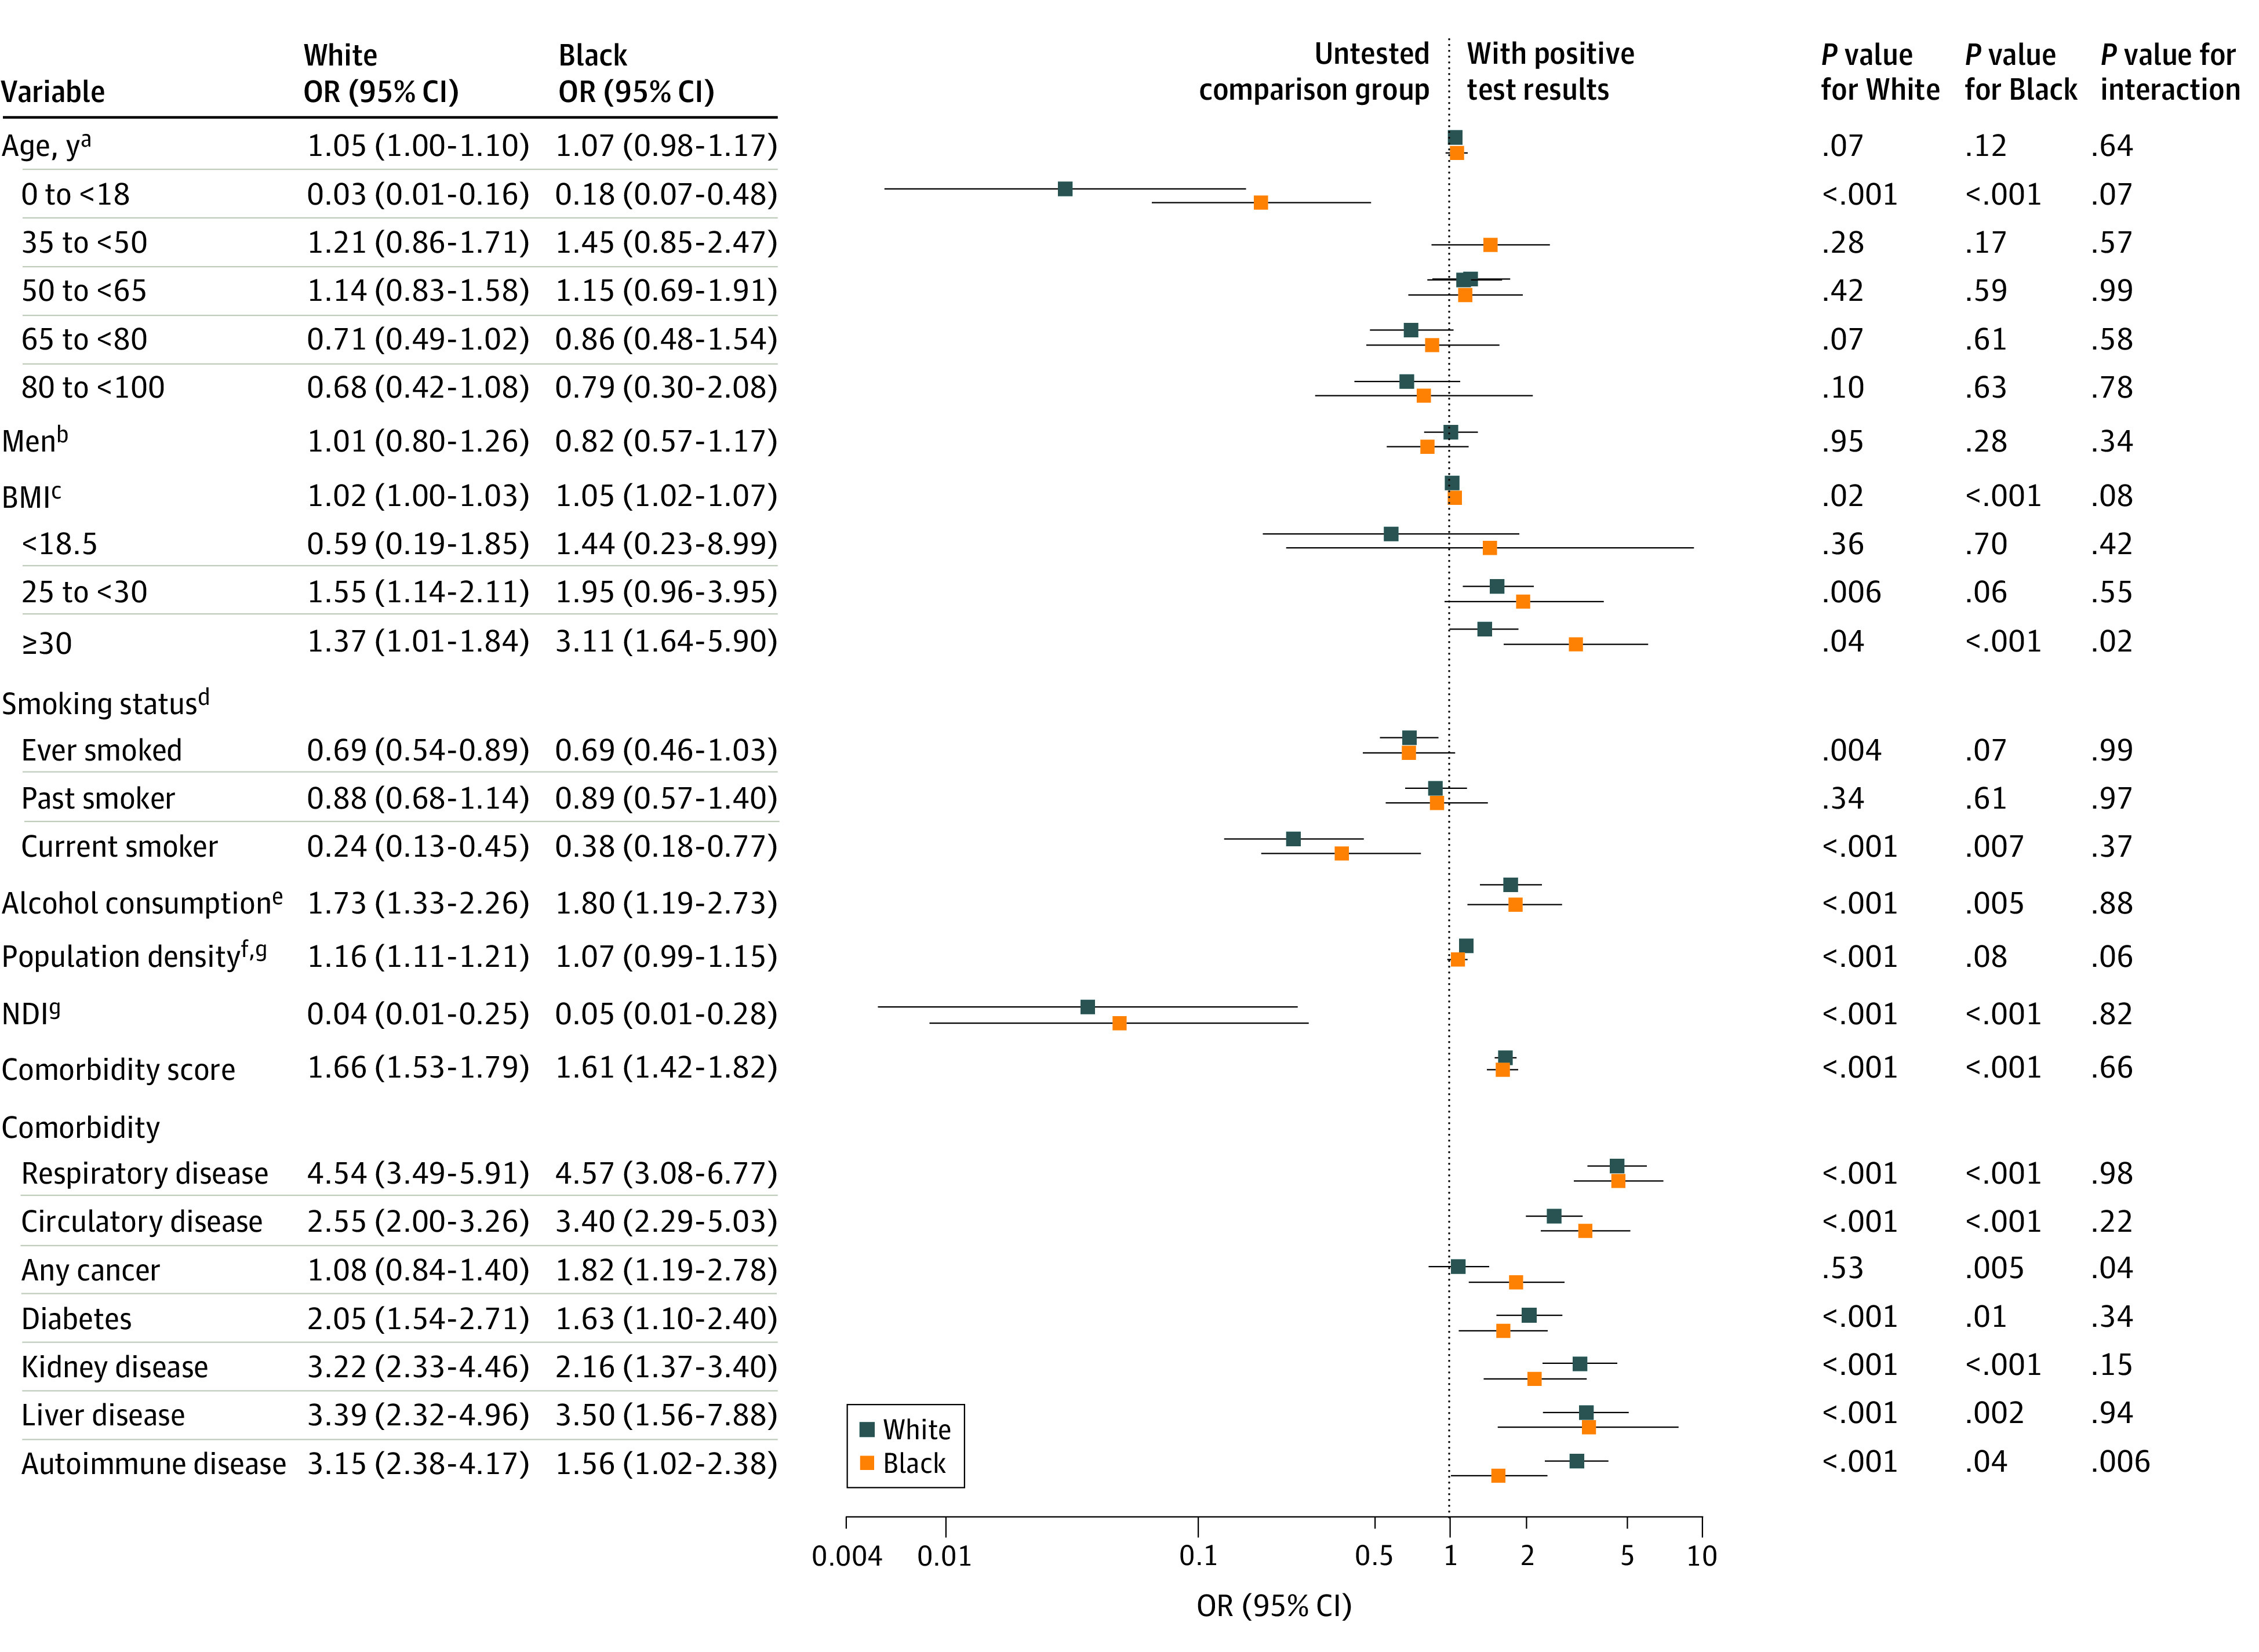
Coronavirus Disease 2019 Susceptibility White and Black PatientsThe results were from model logit P(YCOVID = 1|X, Covariate) = β0 + βXX + βRaceRace + βintX × Race + βcovCovariate, in which Covariate = age + sex + NDI (+ comorbidity score in demographic and socioeconomic status models).aReference: age 18 to younger than 35 years.bReference: women.cReference: body mass index (BMI; calculated as weight in kilograms divided by height in meters squared) 18.5 to less than 25.dReference: never smoker.eReference: no alcohol consumption.fPer 1000 persons per square mile.gFrom 2010 census data.